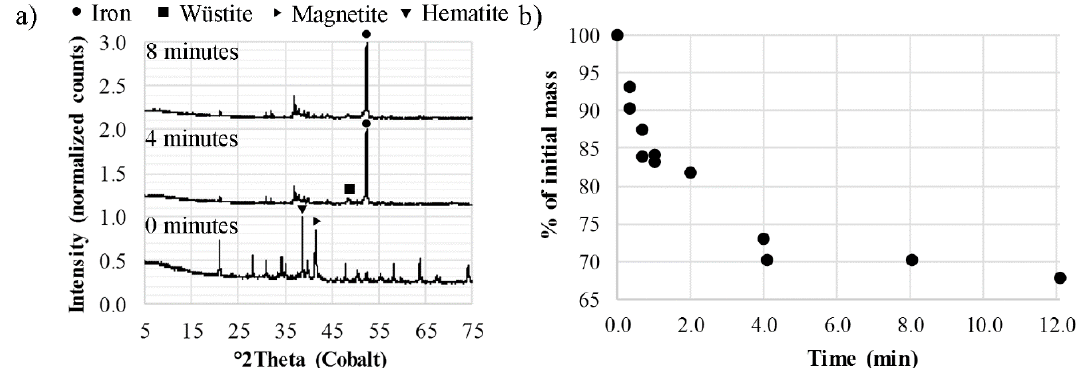
Figure 7. ( a ) Diffractograms of pellets with 100% peaks of the iron phases denoted; ( b ) mass loss of the pellets with respect to the time of contact with hot metal at 1350 °C [30].